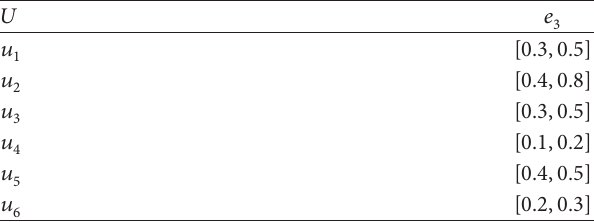
Table 5: Tabular representation of the IVF soft set B .